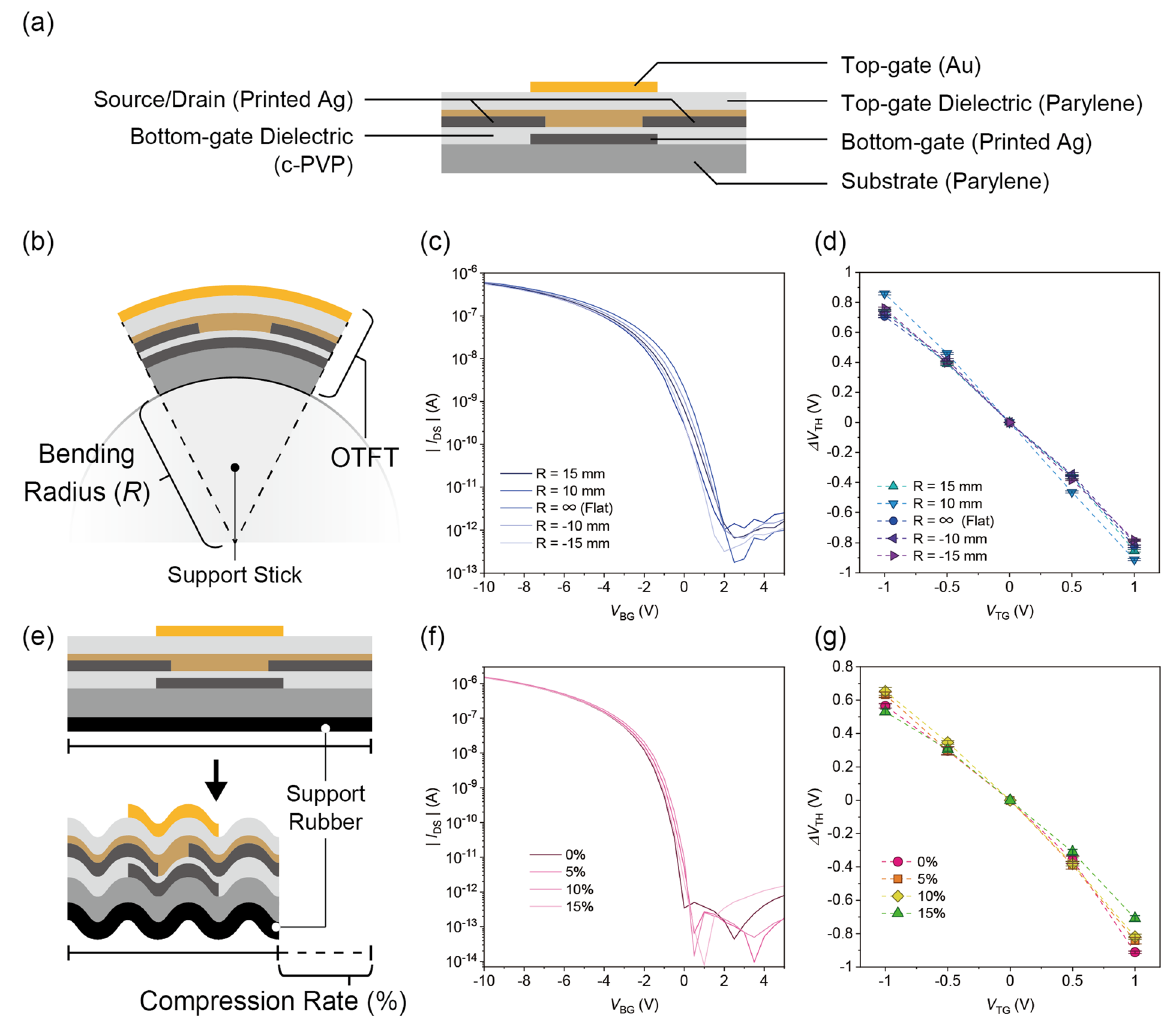
Fig. 3 Mechanical durability of the fl exible OTFT. a Diagram of the fl exible OTFT. b Illustration of the fl exible OTFT device under tensile strain. c Transfer characteristics of the fabricated OTFT before, during, and after application of bending stress. The applied V TG was kept at 0 V. d Changes in the threshold voltage ( V TH ) of the dual-gate OTFT at each radius of curvature. The number of measurement cycles for each condition was fi ve. e Illustration of the fl exible OTFT device upon applying compressive stress. f Transfer characteristics of the OTFT device before, during, and after application of compressive stress. The applied V TG was kept at 0 V. g Changes in the threshold voltage ( V TH ) of the dual-gate OTFT at various compression rates (0%, 5%, 10%, and 15%). The number of measurement cycles for each condition was fi